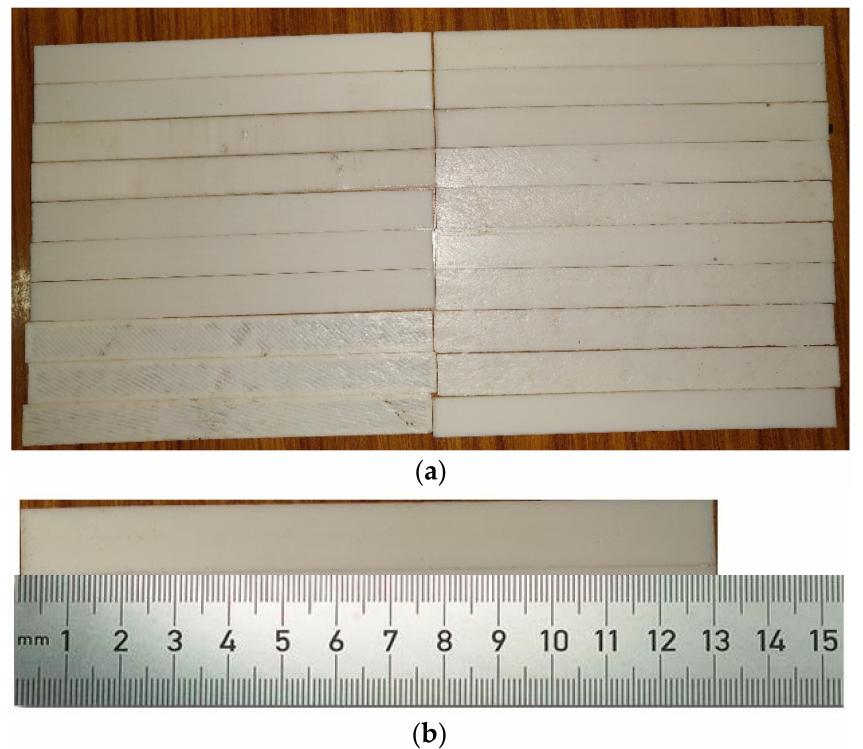
Figure 13. ( a ). Printed specimens for flexural test as per the experimental design. ( b ). Printed flexural specimen with scale.